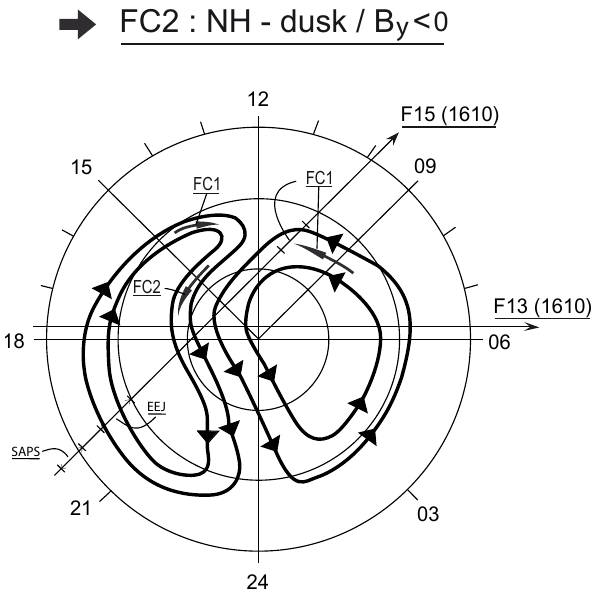
Fig. 1. Flow channel FC 2 (bold arrow) in the context of Dungey convection cells (flow lines) and flow channels FC 1 representing southwest ( B z < 0; B y < 0; | B z /B y | < 1) IMF conditions. (Adapted after Fig. 2 in Greenwald et al., 2002). Trajectories of satellites DMSP F13 and F15 which crossed through flow channels FC 2 and FC 1, respectively, have been marked in the